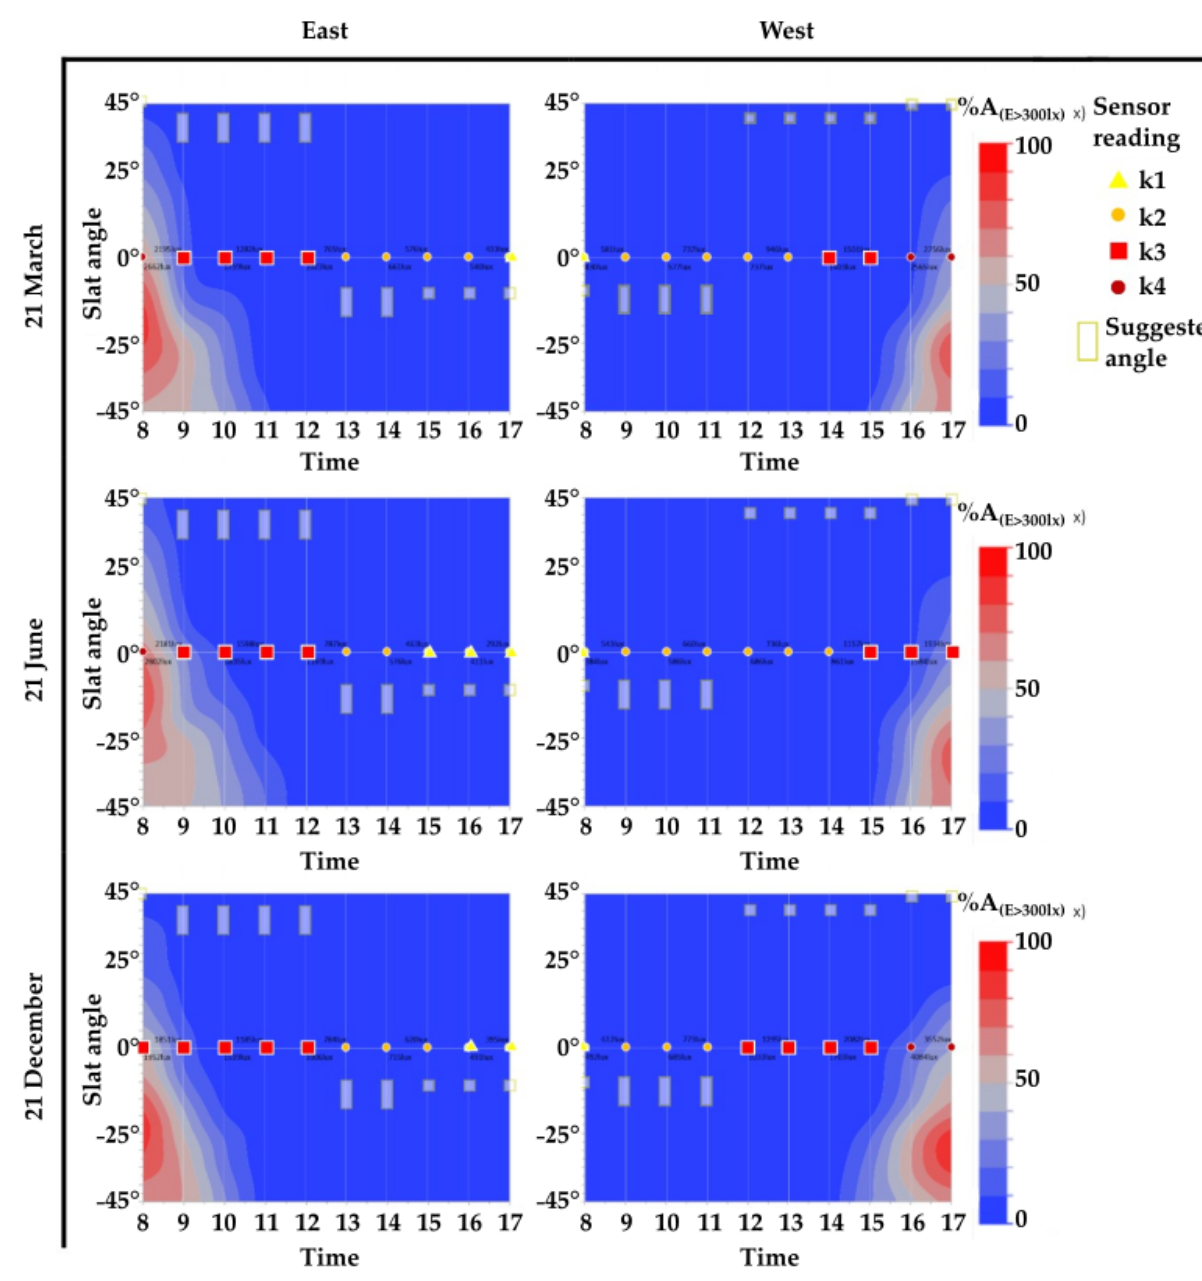
Figure 12. Relations between slat angle and time with respect to ASE 1000,250 in the east and west zones on 21 March, 21 June, and 21 December.